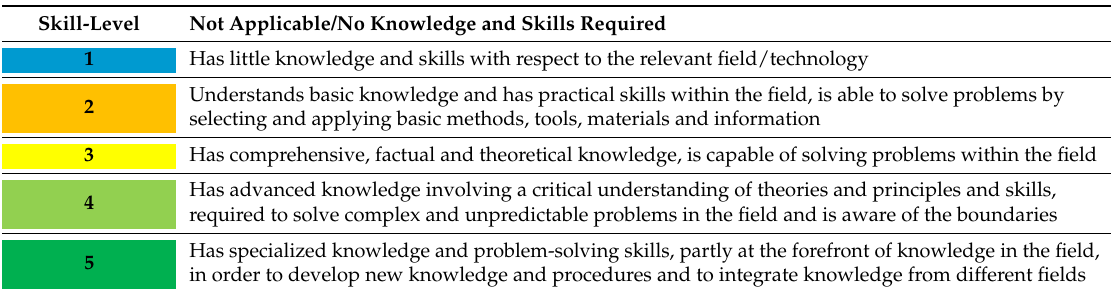
Table 1. Definition of the skill levels used in